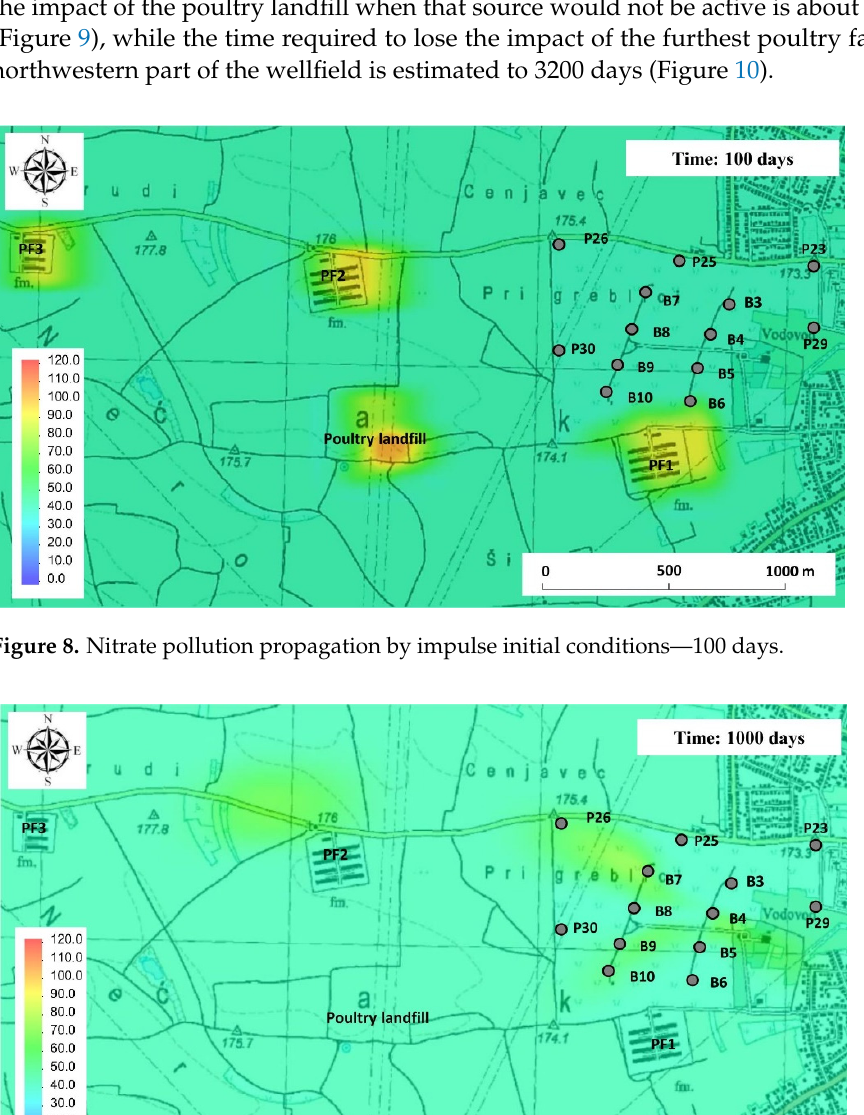
Figure 7. Nitrate pollution propagation.